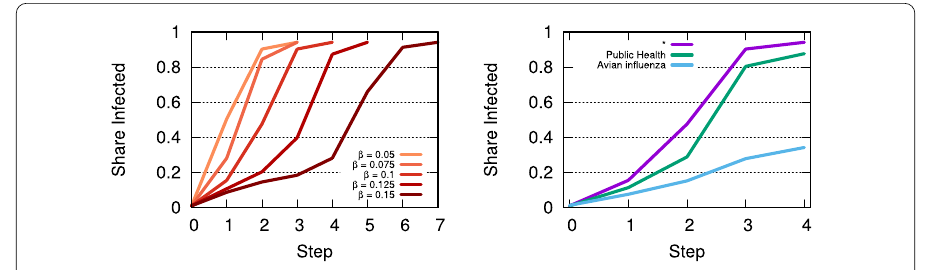
Figure 9 Different infection dynamics in the organization-organization citation network. The lines end when no further infections are recorded in the model. (Left) Infection dynamics considering all edges for different values of the infection parameter β . (Right) Infection dynamics for β = 0.1 for different keywords: overall (purple), Public Health (green), Avian Influenza